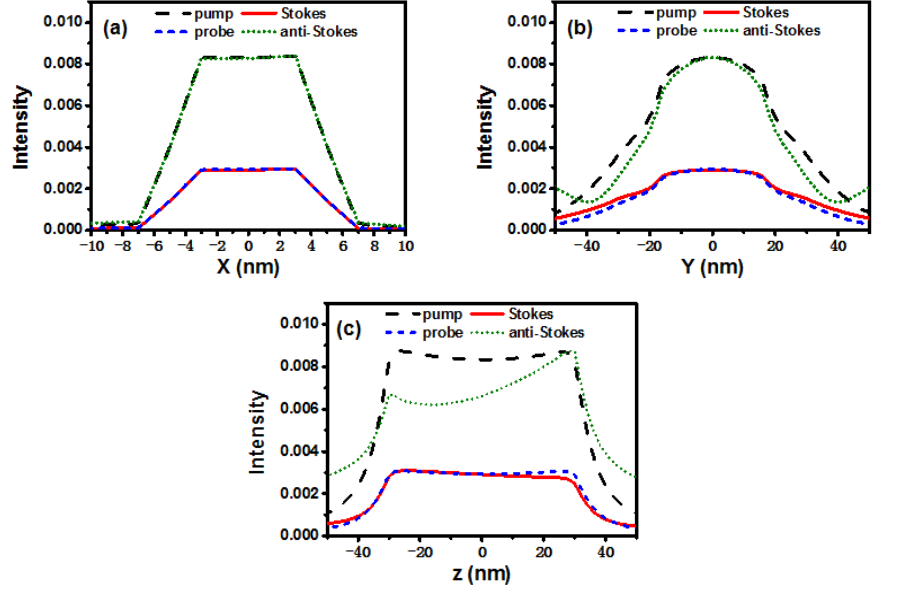
Figure A10. Distributions of the electric field intensity in ( a ) X, ( b ) Y, and ( c ) Z axes for the pump, Stokes, probe, and anti-Stokes light at 7128.3 fs.